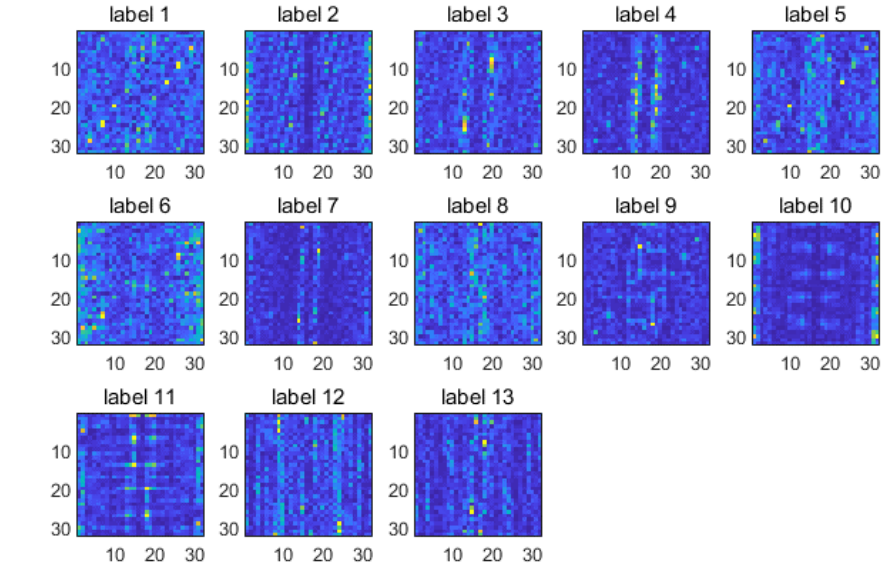
Figure 8. Raw data of bearing vibration signals of different labels.